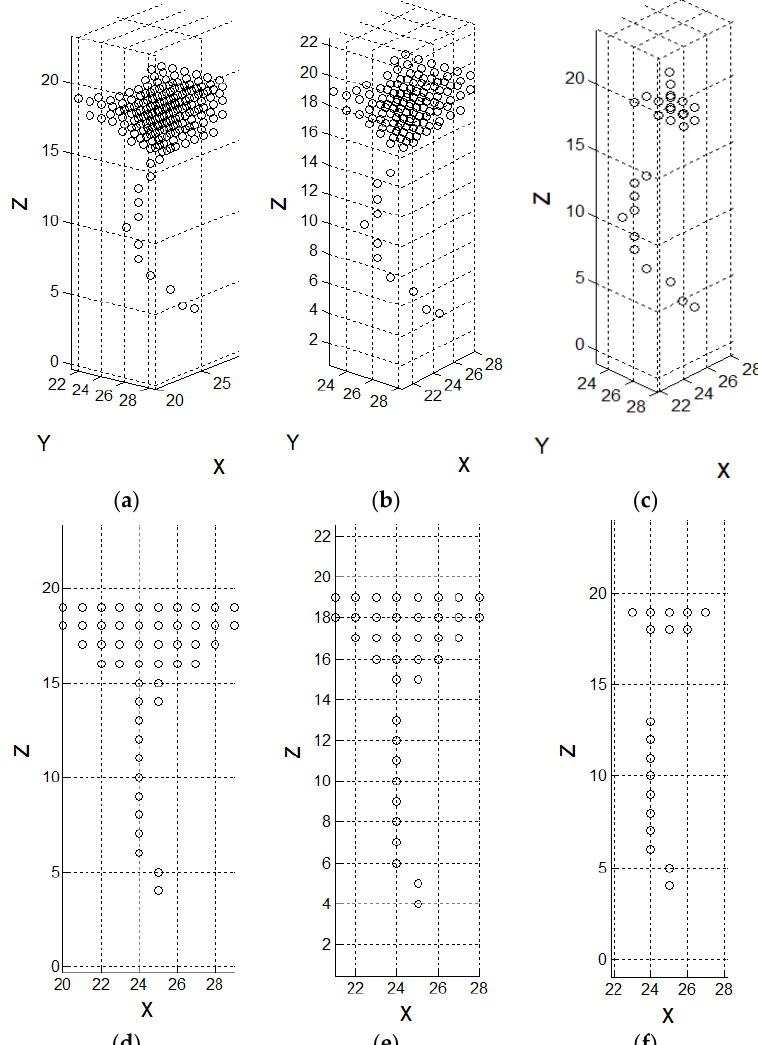
Figure 1. An example of a damaged skeleton. ( a ) An initial state of a part of a 3D model shown in 3D; ( b ) A result shown in 3D after a thinning procedure; ( c ) A result shown in 3D after three times of thinning procedures; ( d ) The initial state of the part shown in 2D; ( e ) The result shown in 2D after a thinning procedure; ( f ) The result shown in 2D after three times of thinning